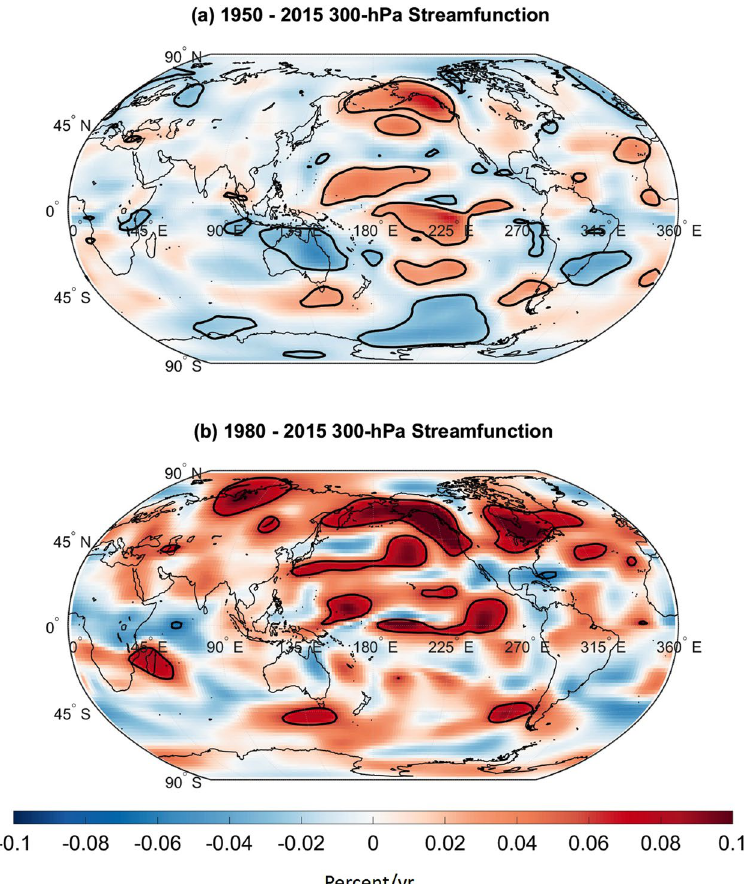
Figure 6. Trends in explained variance. ( a ) Average trend in explained variance calculated using scale-averaged coherence between temperature and 300-hPa streamfunction from 1950 to 2015. The average was computed by averaging the scale-averaged coherence trends associated with 17 US climate divisions whose R 2 trends exceeded the 95 th percentile of all trends calculated in the sliding correlation analysis. Black contours enclose regions of statistically significant trends. ( b ) Same as ( a ) but for 300-hPa streamfunction from 1980 to 2015. The map was generated using MATLAB’s geoshow routine (MATLAB 2015a, http://www.mathworks.com/products/